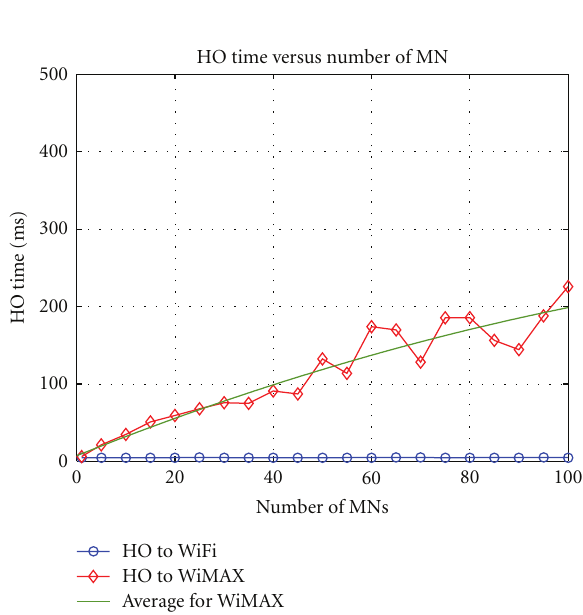
Figure 11: HO time versus no. of MNs.